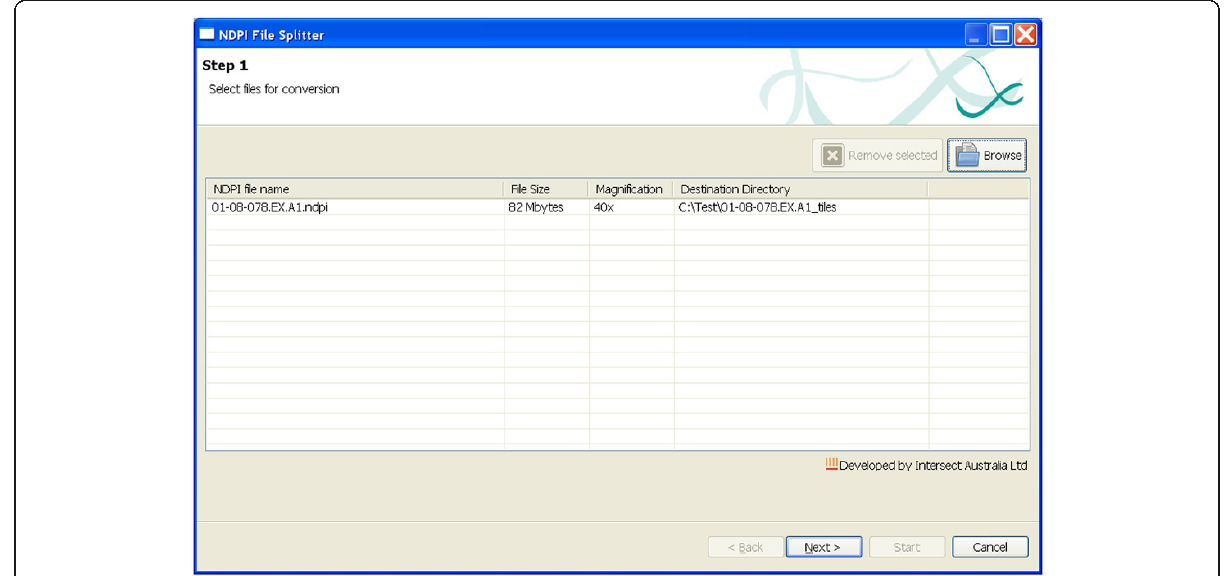
Figure 4 Step-1 of NDPI-Splitter: Graphical User Interface (GUI) makes it easy to select file(s) for